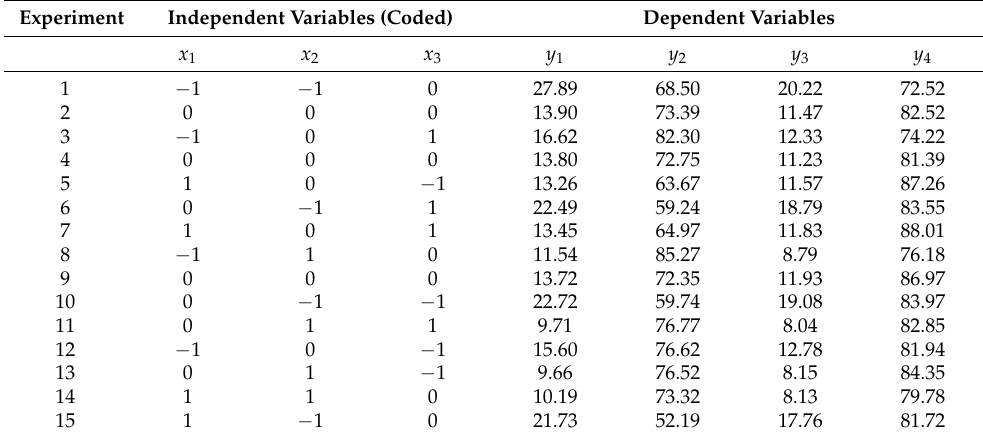
Table 4. Coded independent variables (pH ( x 1 ), solid/liquid ratio ( x 2 ), contact time ( x 3 )) values considered in this study and experimental results obtained for all dependent variables: sorption capacity ( y 1 ), removal of lactic acid ( y 2 ), desorption capacity ( y 3 ) and recovery of lactic acid ( y 4 ). Experiment Independent Variables